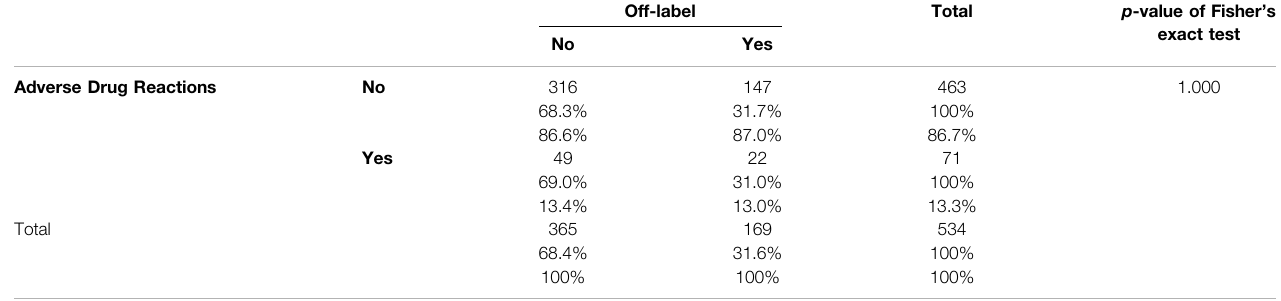
TABLE 3 | Two-way relative frequency table between ADRs and off-label prescriptions.